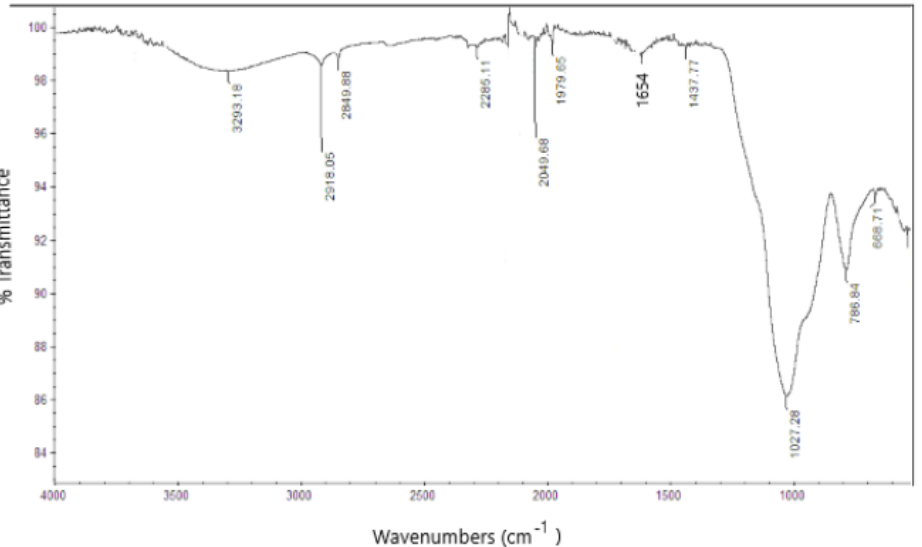
Figure 4. ATR-FTIR spectra of rice husk (own source) acquired at room temperature by a Nicolet FTIR iS10 spectrometer (Nicolet, Madison, WI, USA) equipped with Smart iTR with diamond plate on organic Carnaroli rice husk. Husk was dried at 45 °C, milled and sieved with a 1000 μ m mesh sieve before analysis. Thirty-two scans in the 4000–600 cm − 1 range at 4 cm − 1 resolution were coadded. The peaks are indexed by the tool “Find Peaks” in the Omnic Spectra software Nicolet, Madison, WI, USA.